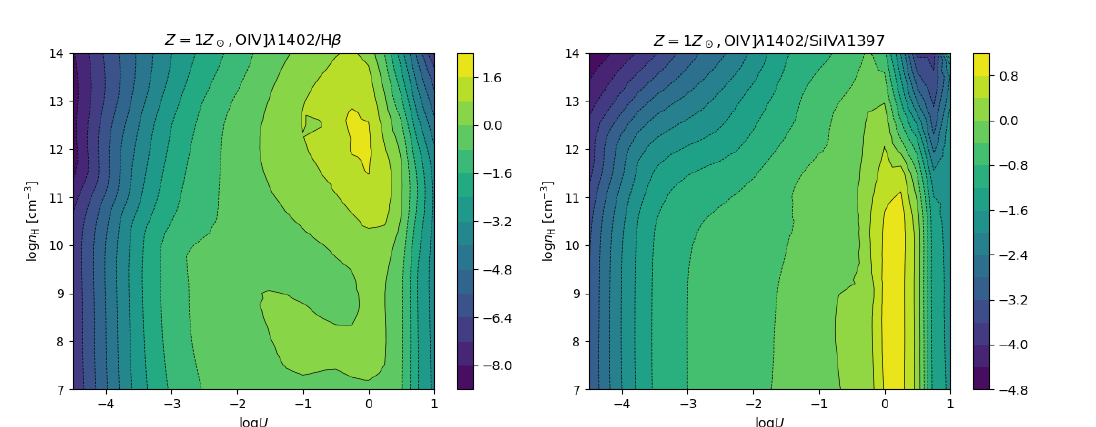
Figure 11. Decimal logarithm of the ratio between the total O IV ] λ 1402 multiplet emission and H β (left) and the total doublet Si IV λ 1397 emission (right), as a function of ionization parameter U and hydrogen density n H